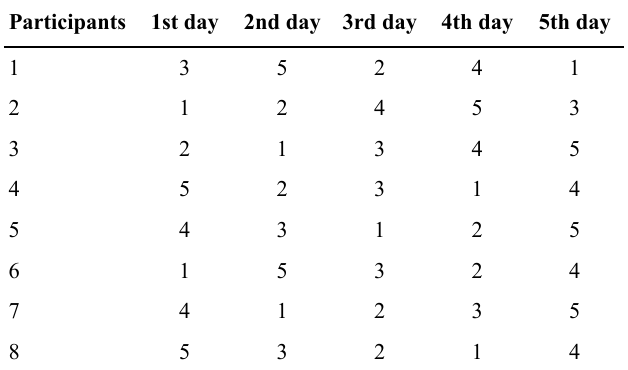
Table 1. Sequence in which each participant performed the warm- up protocols. The interventions are coded as follows: 1 = control; 2 = resistance exercise; 3 = bicycling; 4 = vertical jumps; 5 = stretching.